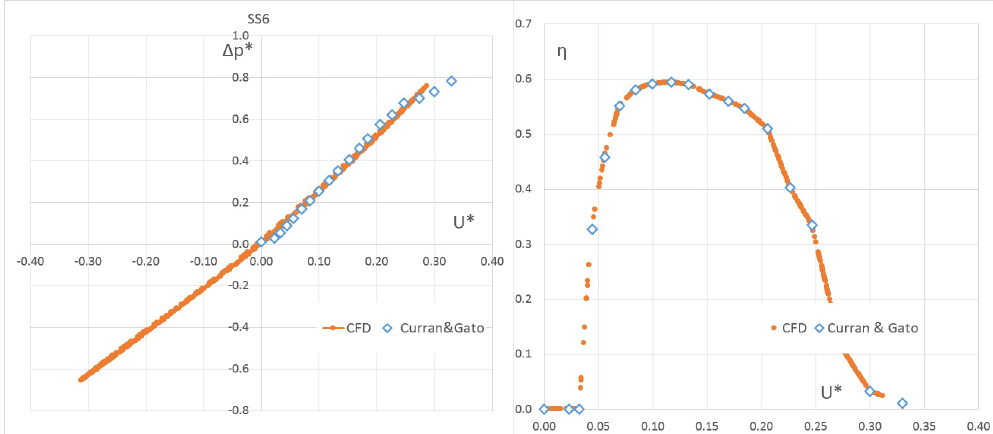
Figure 19. Equivalent characteristic curves of the Wells turbine (SS6).